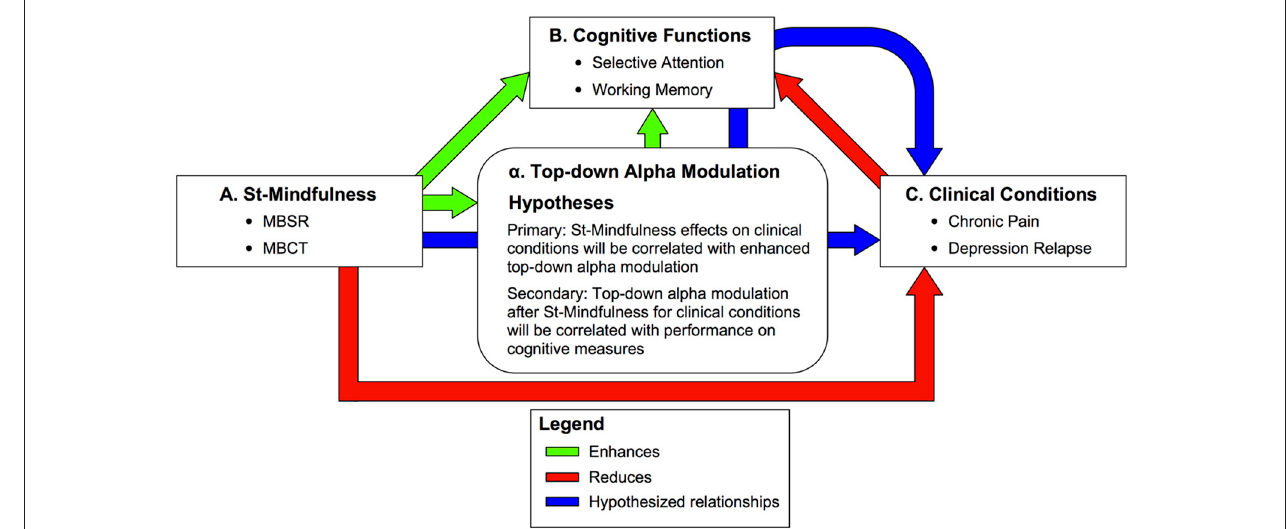
FIGURE 1 | Summary of predictions on the effects of Standardized Mindfulness Training (ST-Mindfulness) on cognitive and clinical conditions through top–down alpha modulation. Green arrows —enhanced functions A → B: ST-Mindfulness enhances